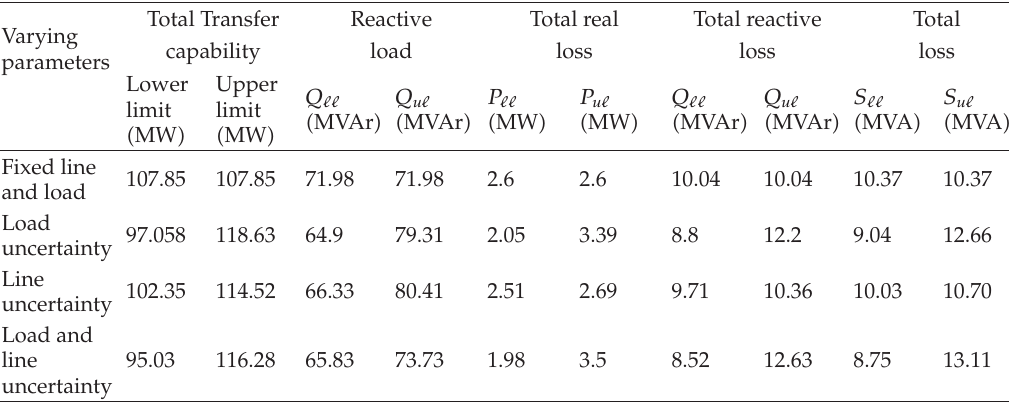
Table 6: Interval values for the operating parameters in case